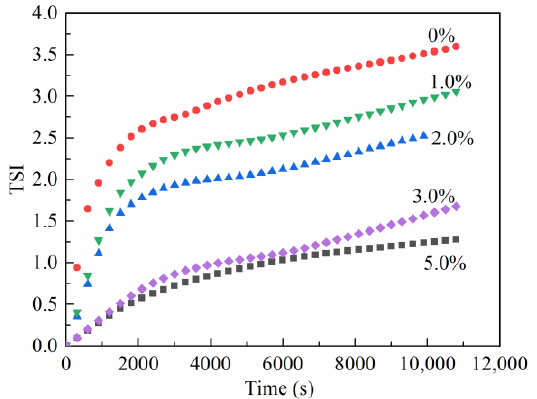
Figure 4. Effect of TQ-1 on the TSI values of the invert emulsions.